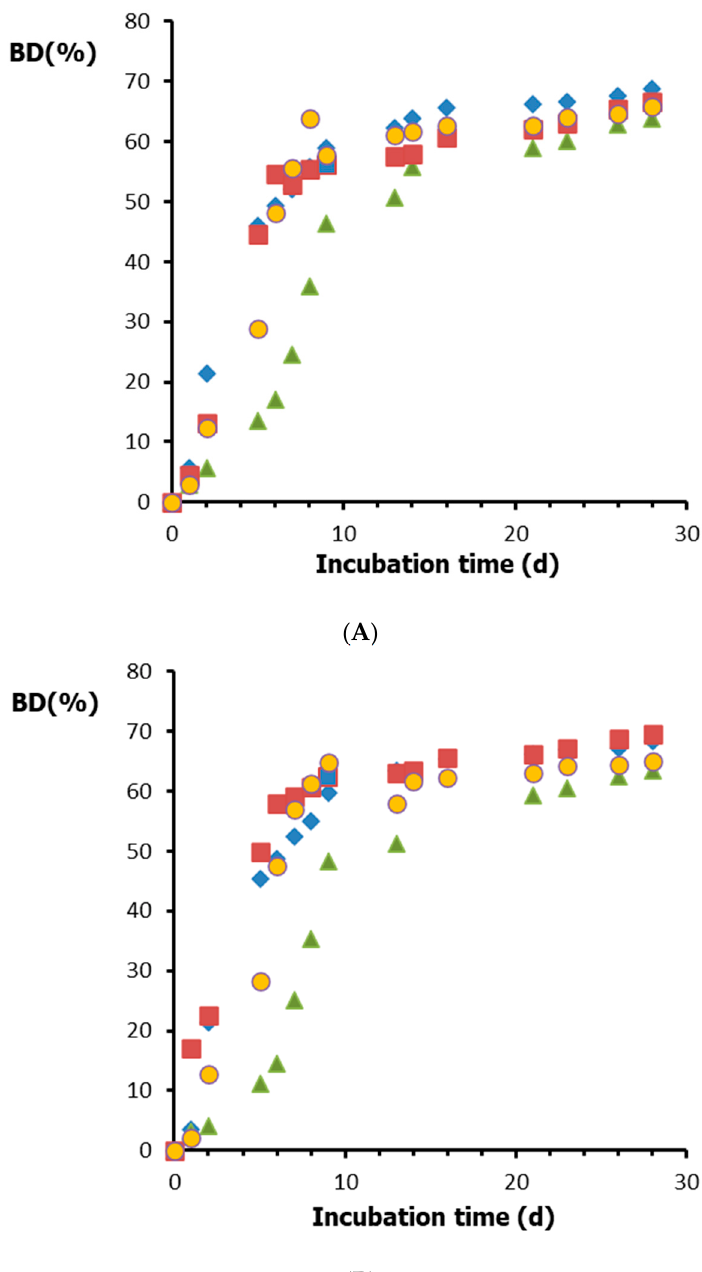
Figure 5. Biodegradation ( BD , mean of two replicates) obtained for the enantiomers of verapamil (VER) in incubated samples during the biodegradability assays: ( ◆ ), biotic assay; ( ▲ ), abiotic as ‐ say; ( ■ ), biotic assay in darkness; ( ⚫ ) biotic assay supplemented with acetate. A: E1 ‐ VER; B: E2 ‐ VER.